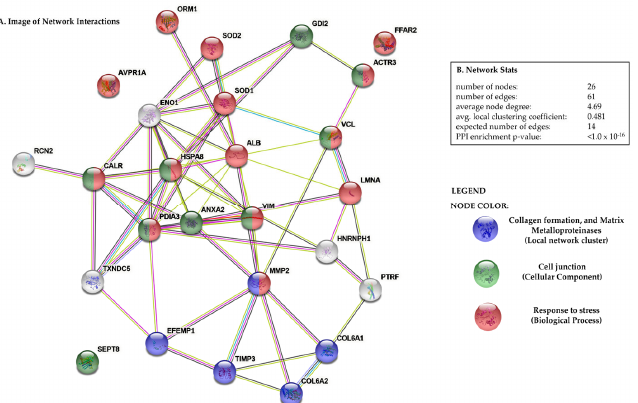
Figure 2. STRING analysis of differentially accumulated proteins and genes between the control and treatment groups in pig aorta. ( A ) Protein–protein interaction image displaying nodes and edges between all porcine aorta proteins and genes. Proteins and genes are represented as nodes. Various thickness of the edges indicates the strength and nature of the presented interactions detected between them. Different colors of nodes display selected GO terms such as biological process (response to stress), cellular component (cell junction) and local network cluster (STRING) (collagen formation, and matrix metalloproteinases) that are closely related with diet-induced changes in porcine aortic wall protein and gene expression patterns. Full name of proteins along with the corresponding genes can be found in Tables 2 and 3. ( B ) Network statistics presents data concerning included number of nodes and edges, the average node degree, the average local clustering coefficient, the expected number of edges, and the protein–protein interaction (PPI) enrichment p